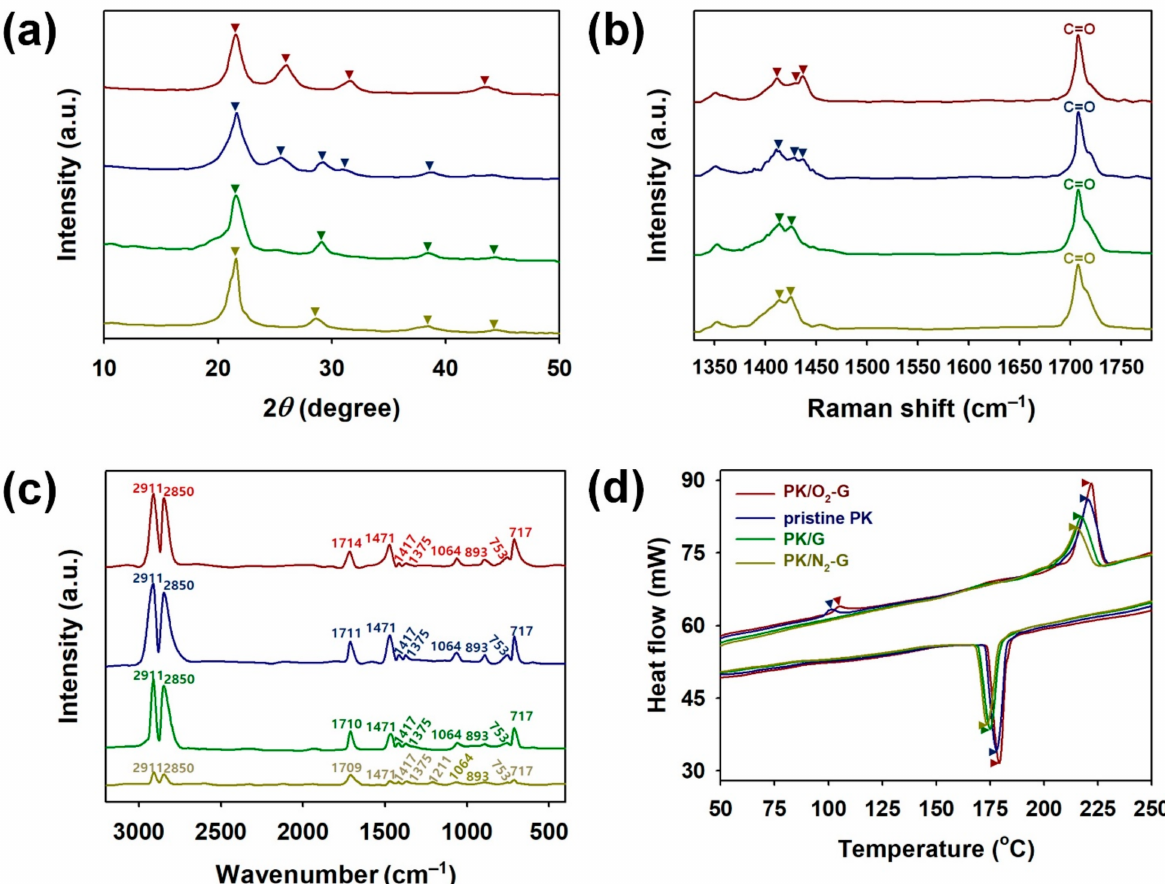
Figure 8. ( a ) XRD patterns, ( b ) Raman spectra, ( c ) FT-IR spectra and ( d ) DSC thermographs of PK/O 2 -G (red), pristine PK (blue), PK/G (green) and PK/N 2 -G (olive